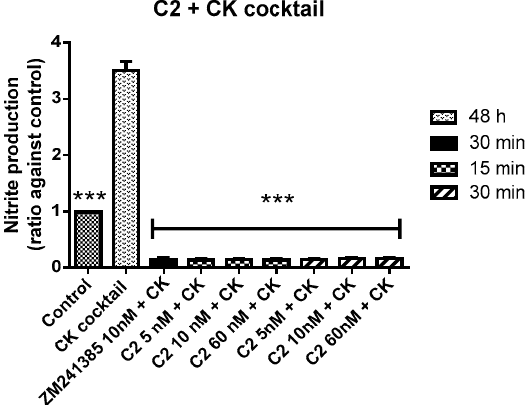
Figure 10. Antioxidant effects of ZM241385 and C 2 after pre-treatment with CK cocktail on mixed glial cell culture. Ratio of NO 2 ¯ production after treatments. Results represent the average of 3 - 5 independent experiments. *** p < 0.001 of treated cells against CK.